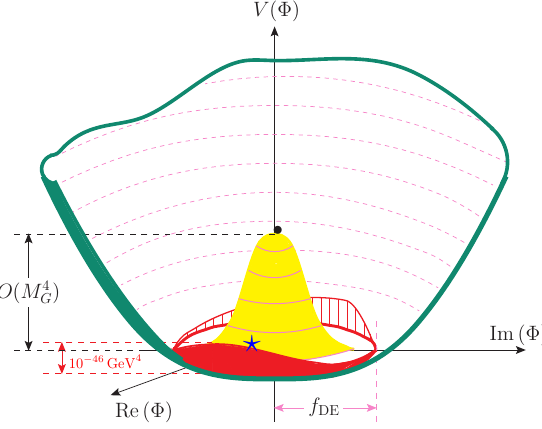
Figure 8. The DE potential in the red angle-direction in the valley of radial field of height